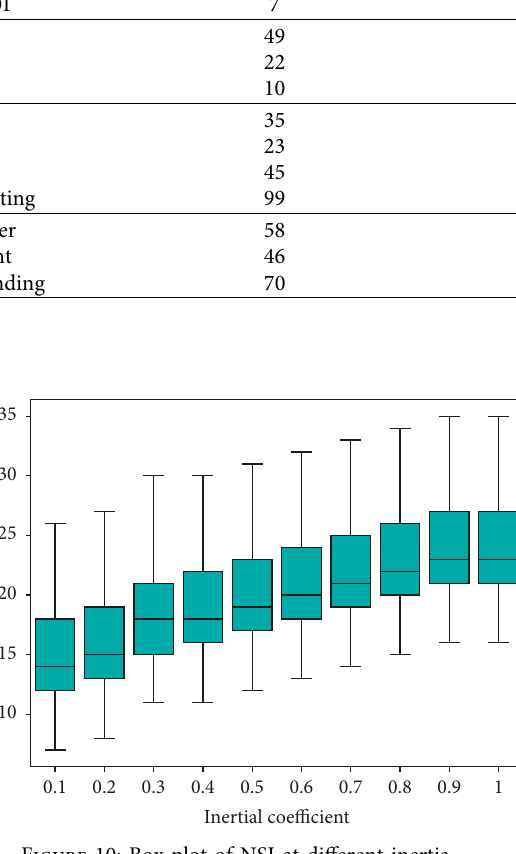
Figure 10: Box plot of NSI at different inertia.